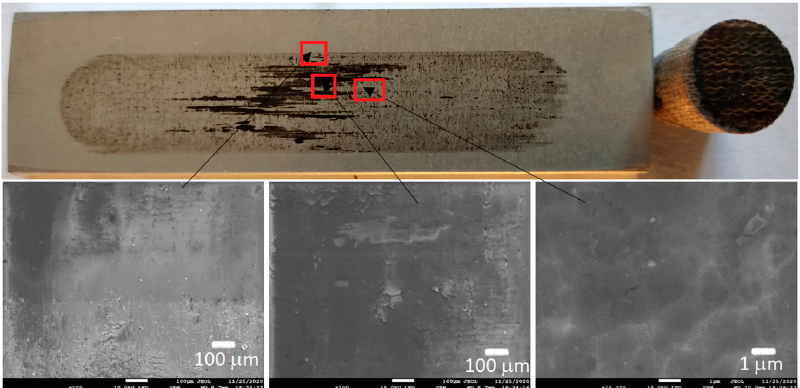
Figure 12. Photographs and SEM micrographs of Al 2 O 3 /IF-WS 2 tribological pairs after a tribological test with PF + cotton + MoS 2 .